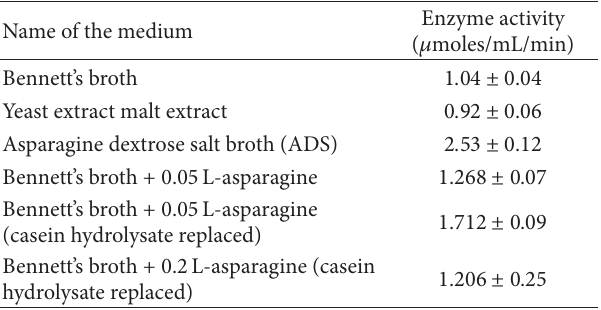
Table 1: L-asparaginase enzyme activity by Streptomyces ginsengisoli on different media.